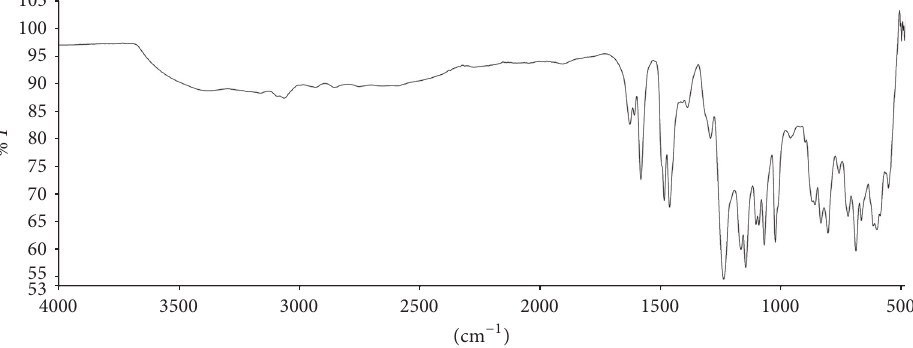
Figure 8: FTIR spectrum of SPAEB copolymer membrane.